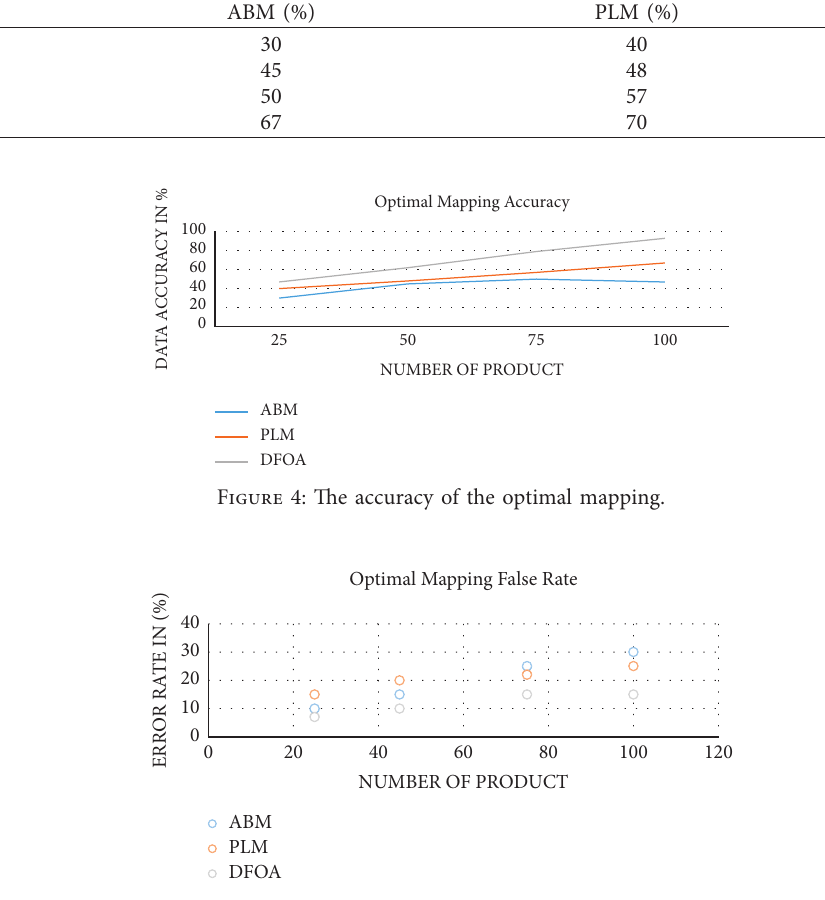
Figure 5: The false rate of the optimal mapping.